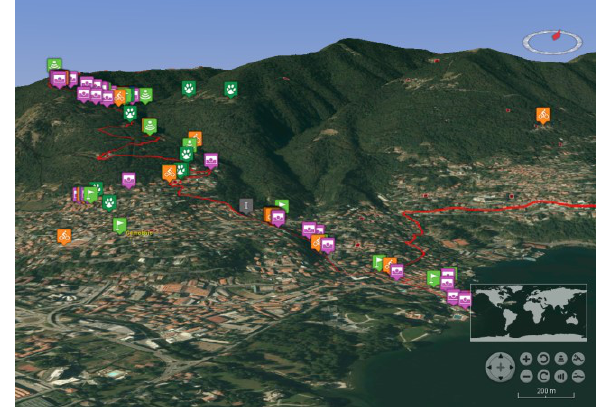
Figure 4. Markers related to the POIs collected by users